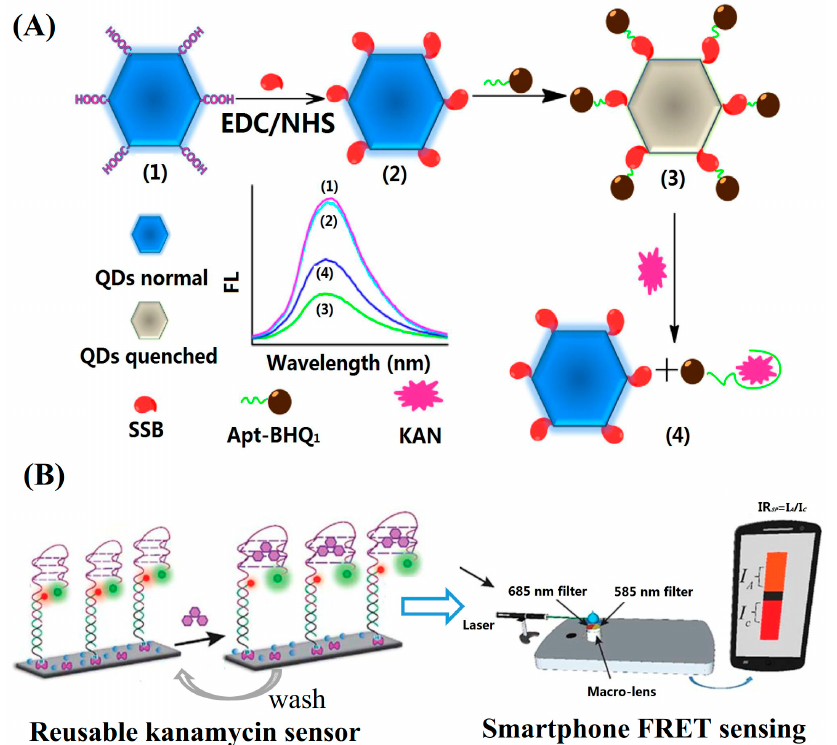
Figure 4. Representative ( A ) turn-on (reprinted with permission from [37] Copyright (2018) Elsevier) and ( B ) ratio FL detection for kanamycin based on fluorescence resonance energy transfer (FRET) (reproduced with permission from [39] Copyright (2019) Royal Society of Chemistry).